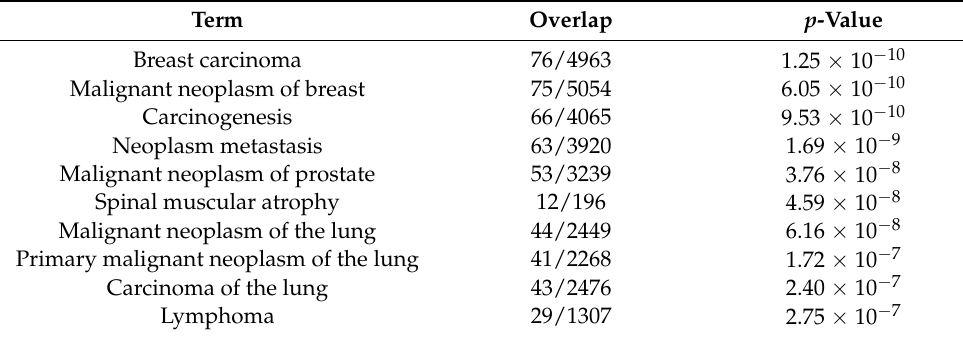
Table 2. DisGeNET gene–disease associations in NGB-KO cells.